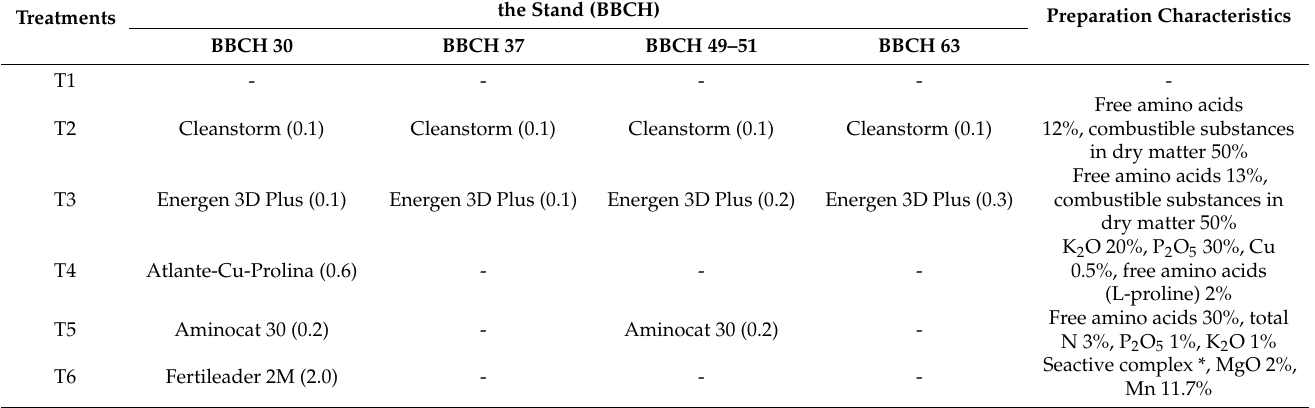
Table 1. Scheme of monitored preparations application and their brief characteristics. For the applied stimulation preparation (T2–T6), the applied dose (L ha − 1 ) for the experimental stands and the period of the application according to the phenological phase (BBCH) of the experimental stand is given.